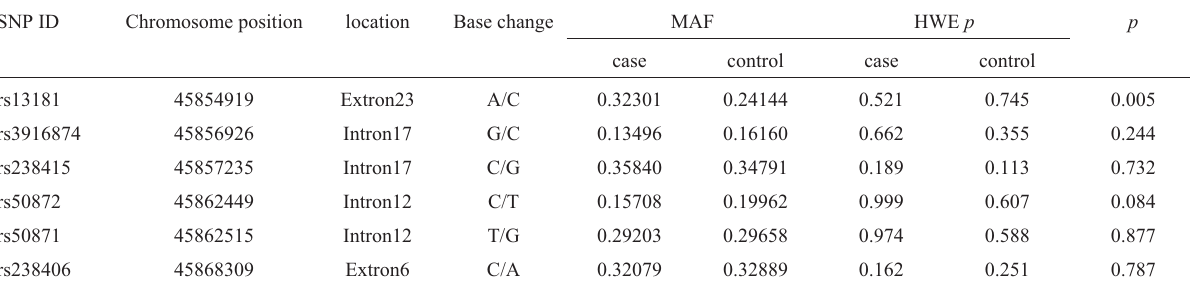
Table 4 - Characteristics of the 6 SNPs in XPD